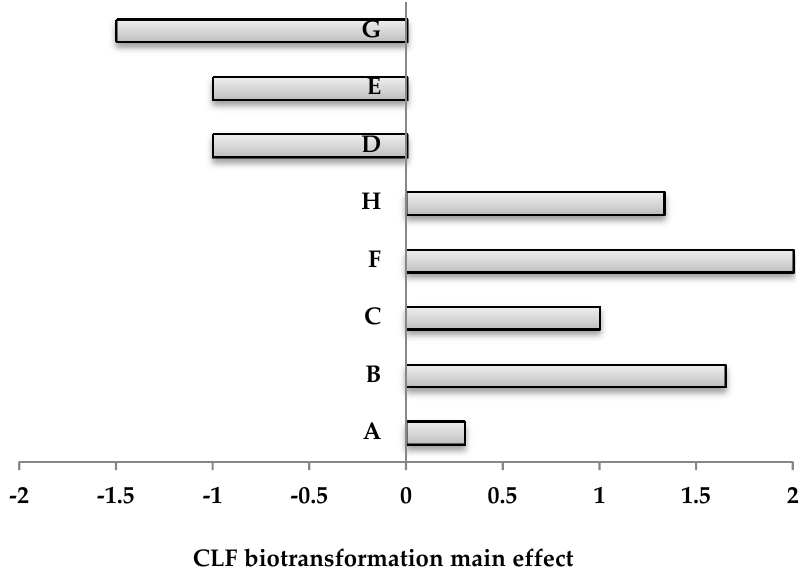
Figure 1. Pareto chart for the e ff ect of independent variables on CLF biotransformation by Trametes pubescens based on PBD analysis.